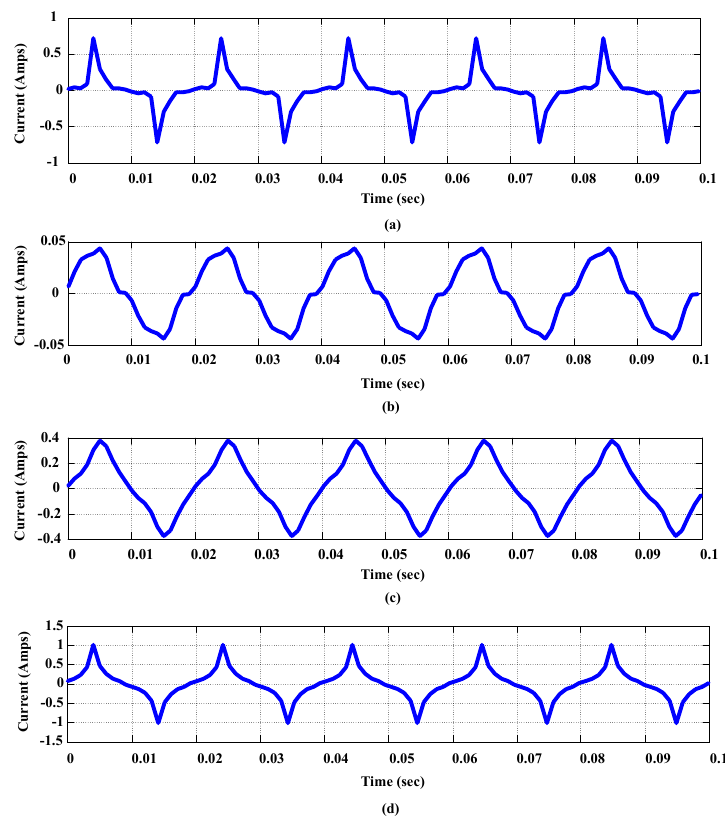
Figure 5. Individual single loads. ( a ) CFL load waveform; ( b ) LED load waveform; ( c ) exhaust fan waveform; ( d ) SMPS of the PC waveform.